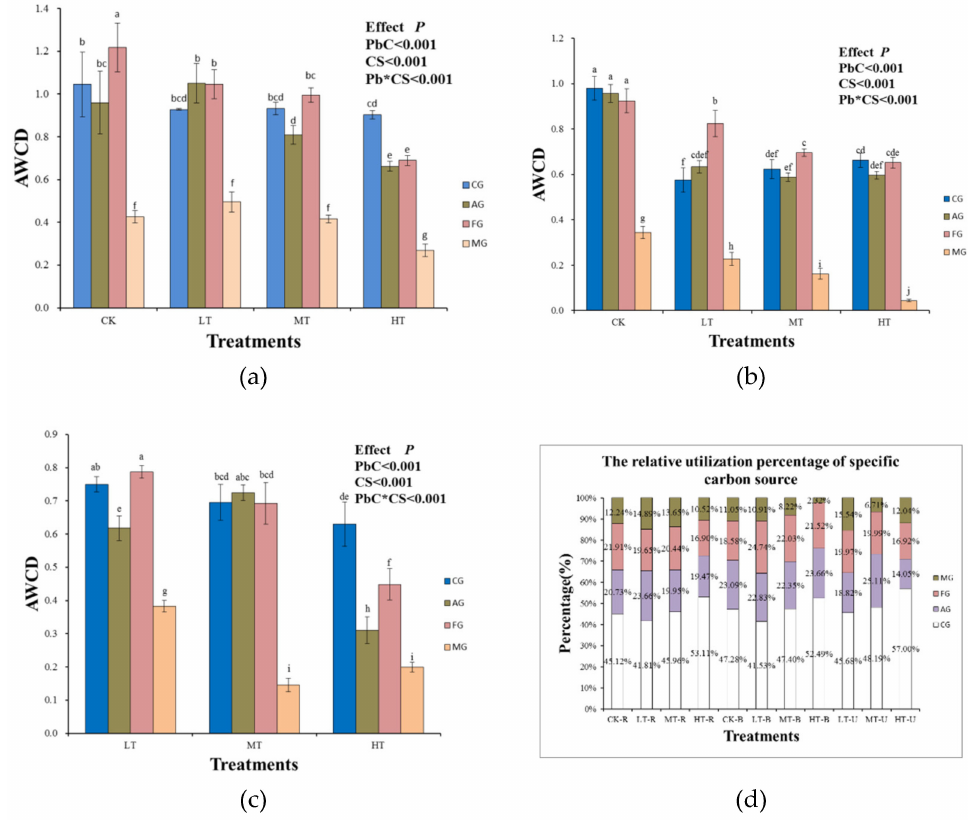
Figure 5. Utilization of the carbon source groups of microbial community of rhizospheric soil ( a ), bulk soil ( b ), unplanted soil ( c ) and the relative utilization percentage of specific carbon source ( d ). PbC, Pb concentrations; CS, carbon sources effect; PbC × CS, the interactive effect of Pb concentrations and carbon sources; CK, 0 mg/kg; LT, 500 mg/kg; MT, 1000 mg/kg, HT, 1500 mg/kg; CG, carbohydrates and their derivatives; AG, amino acids and their derivatives; FG, fatty acids and lipids; MG, metabolic mediates and secondary metabolites. Different letters indicate that values differ significantly at p < 0.05. Values represent mean ± SD ( n =